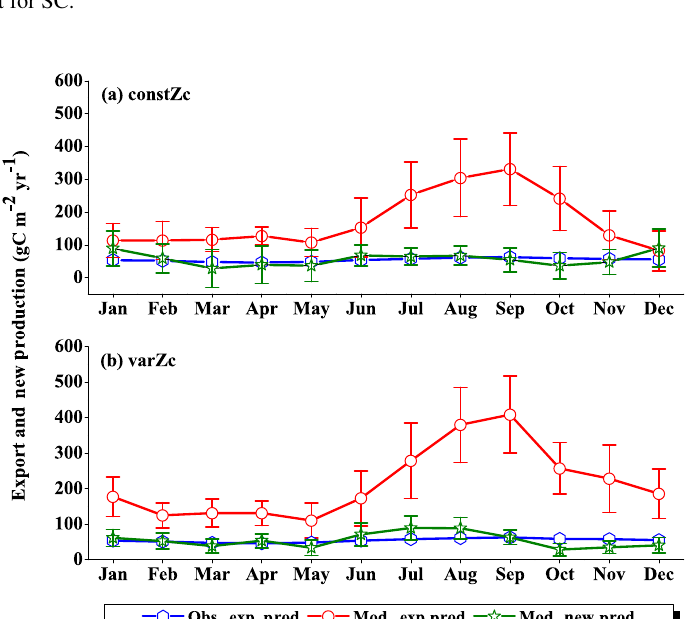
Figure 12. Same as Fig. (6), but for SC.